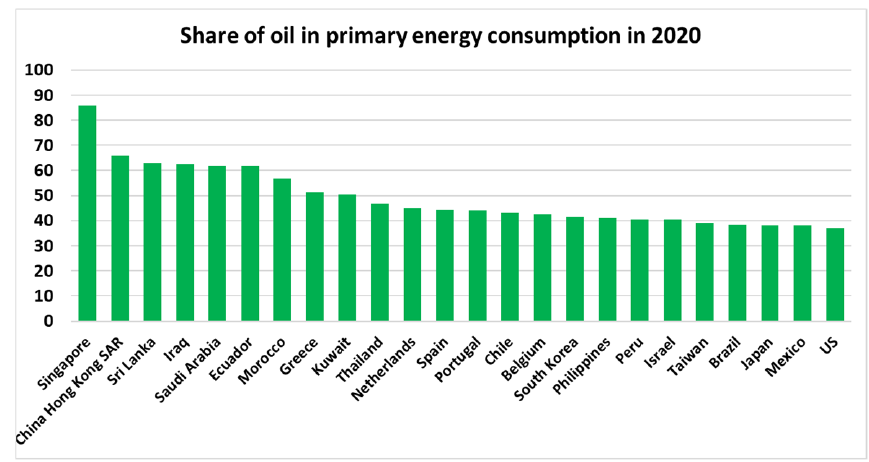
Figure 6. Countries in which the shares of oil in primary energy consumption are the largest in 2020, % [5].